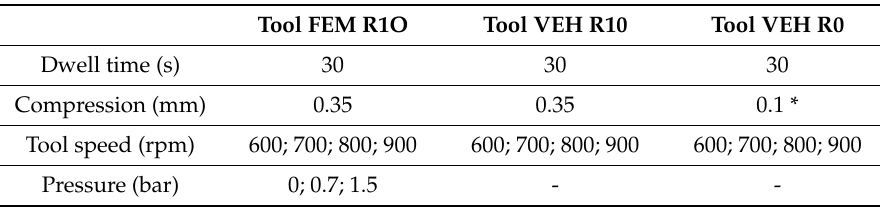
Table 1. Spot experiment